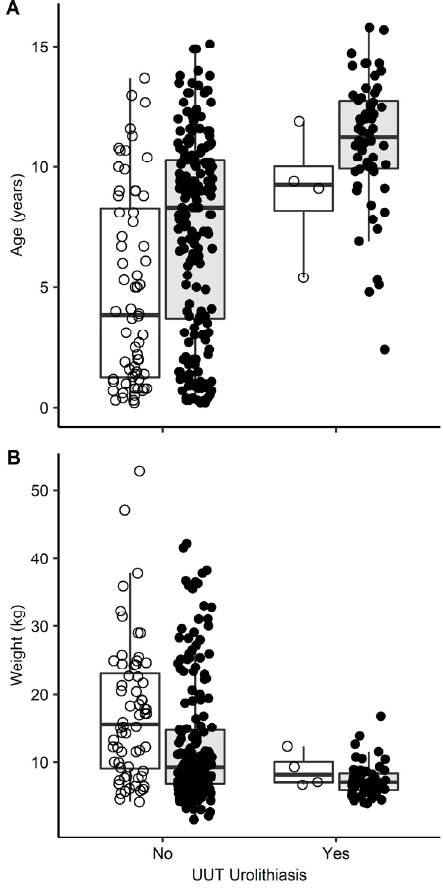
Figure 1. Box and whisker plots of ( A ) age and ( B ) weight for 319 dogs with abdominal radiographs reviewed for upper urinary tract (UUT) urolithiasis. Dogs of breeds at increased risk for calcium oxalate urolithiasis ( n = 251) are represented with closed dots and grey shaded boxes and mixed breed dogs ( n = 68) are represented with open dots and open boxes. The boxes represent the interquartile range, and the whiskers represent 1.5 times the interquartile range. Dogs with UUT uroliths were older and weighed less than those without ( p < 0.001 for both comparisons).